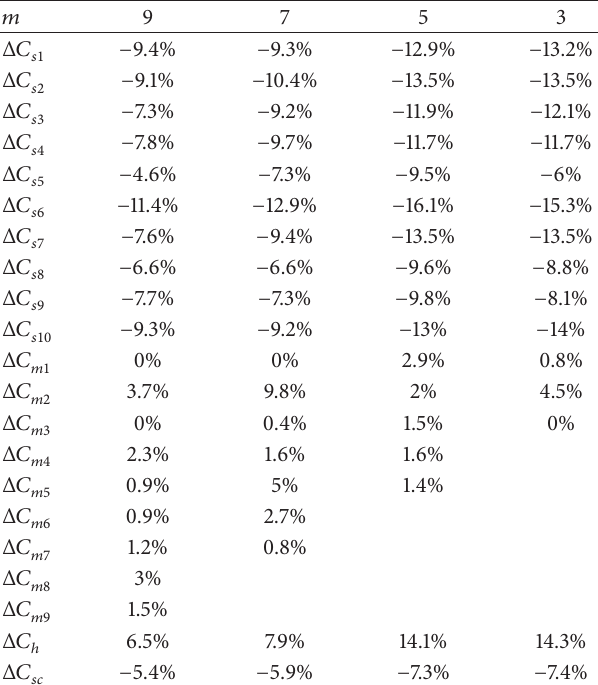
Table 4: The difference of every cost item when 𝑛 = 10 .